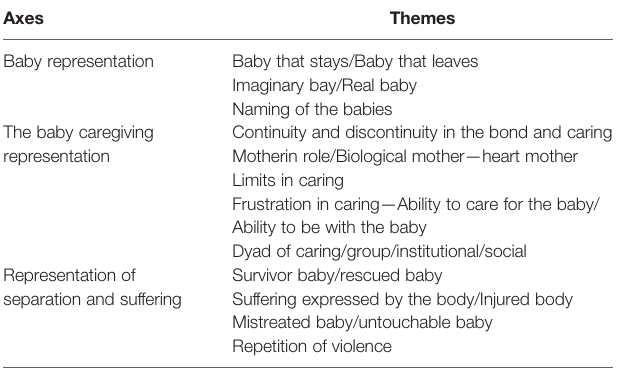
Axis 1: Representation of the Baby